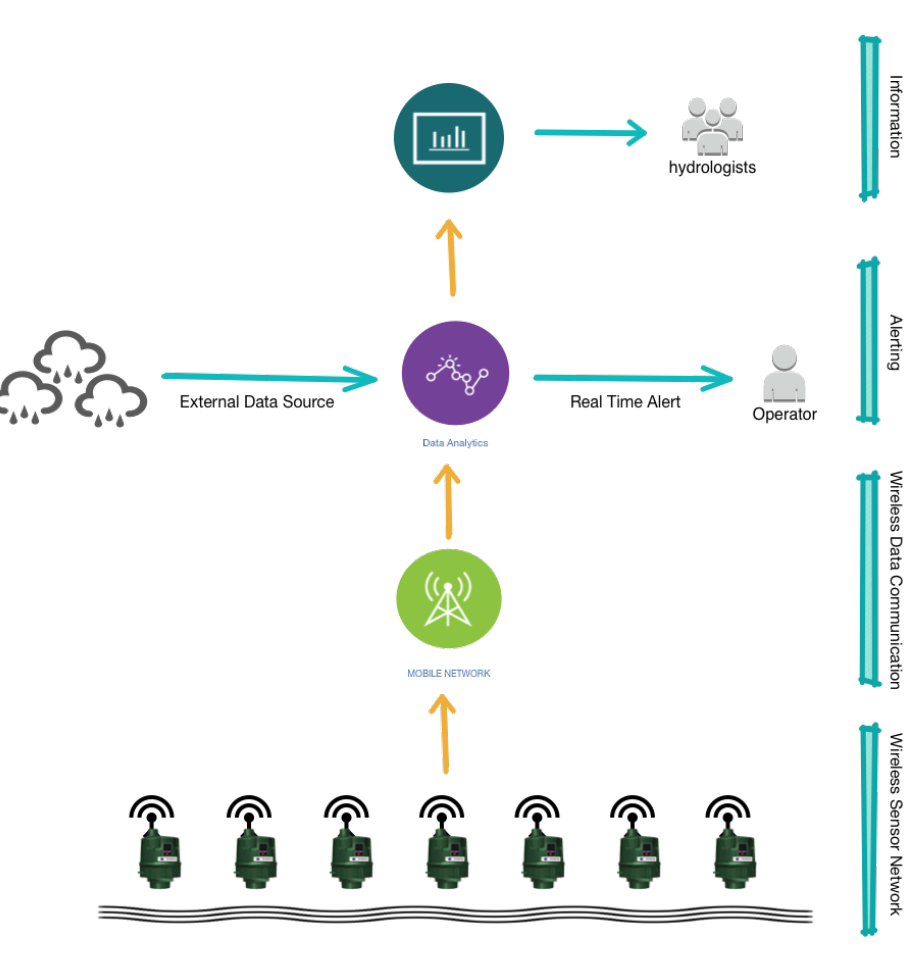
Figure 1. The architecture of the proposed end-to-end pipeline of catchment monitoring using low-cost smart sensor